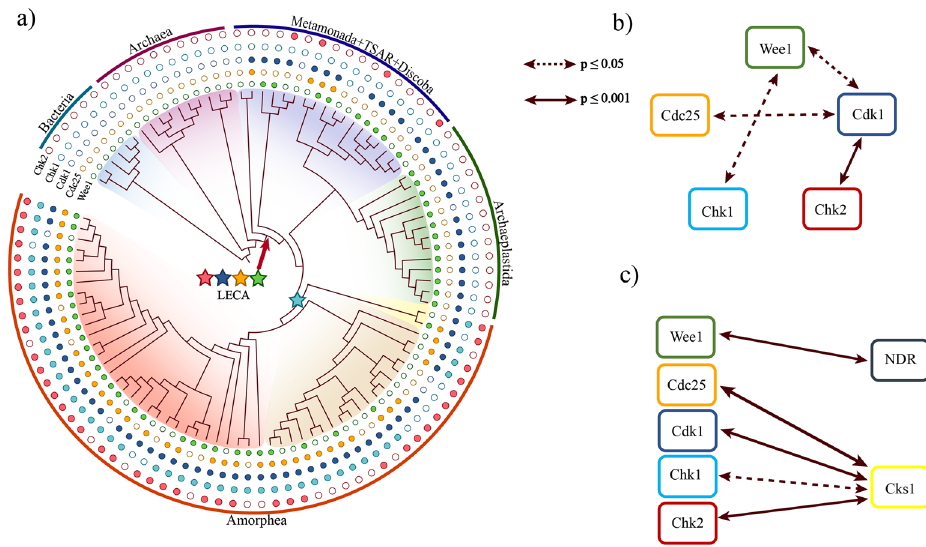
Figure 4. Phylogenetic analyses of Wee1, Cdc25, Cdk1, Chk1 and Chk2. ( a ) Phylogenetic tree (424 species pruned to 100 species for clarity. See the complete phylogenetic tree in Supplementary Fig. S2) with the presence and absence of Chk2, Chk1, Cdk1, Cdc25 and Wee1. Wee1, Cdc25, Cdk1 and Chk2 were present in the last eukaryotic common ancestor (LECA, red arrow), and they were lost several times. Chk1 emerged